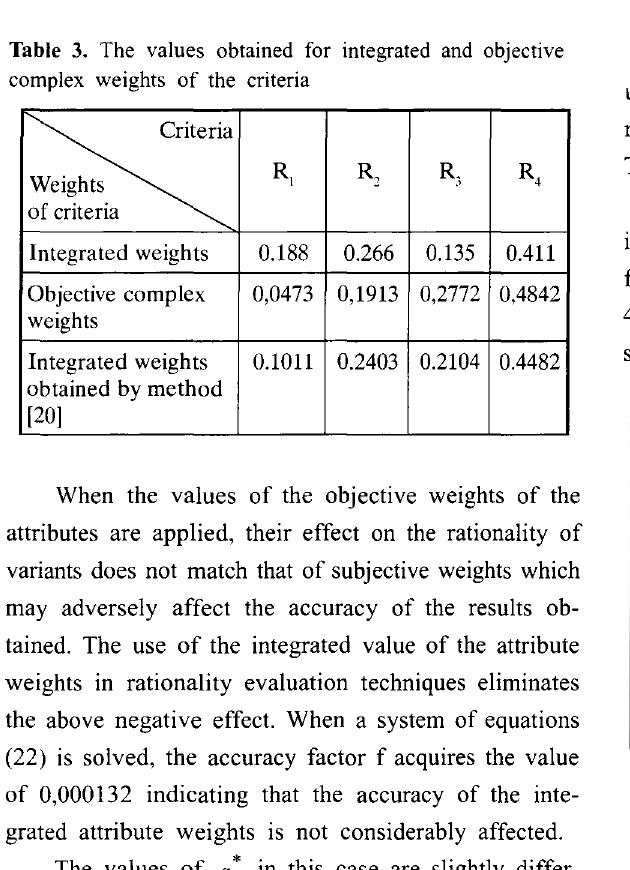
Table 3. The values obtained for integrated and objective complex weights of the criteria